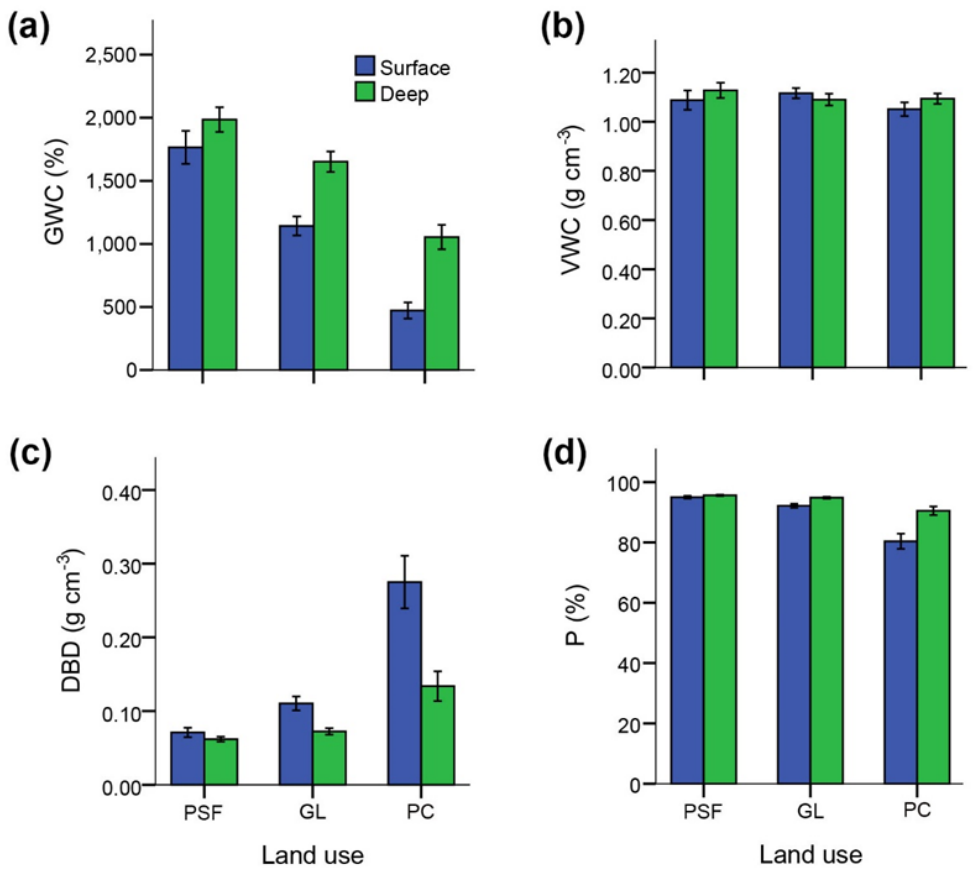
Figure 3. The difference in (a) gravimetric water content (GWC), (b) volumetric water content (VWC), (c) dry bulk density (DBD) and (d) total porosity (P) of peat soils in the different land use conversion classes in the study area. Average values for land conversion classes and standard error bars are shown. PSF=peat swamp forest, GL=grassland, PC=cultivation, surface peat layers (0–20, 20–40 cm), deep peat layers (40– 60, 60–80, 80–100